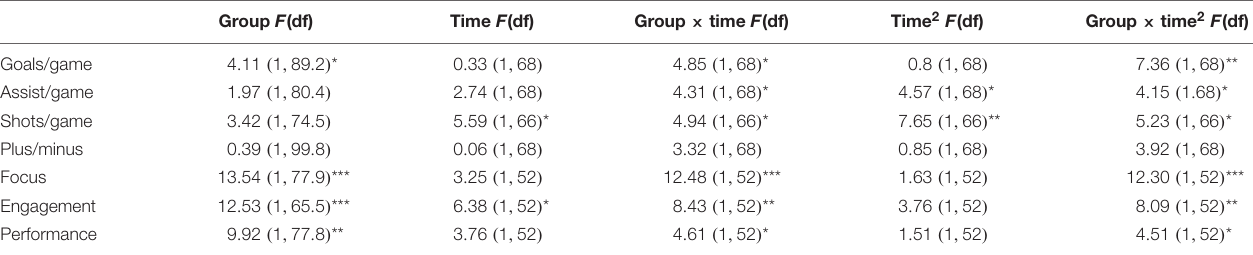
TABLE 2 | Group, time, squared time and interaction effects from the mixed model repeated measures